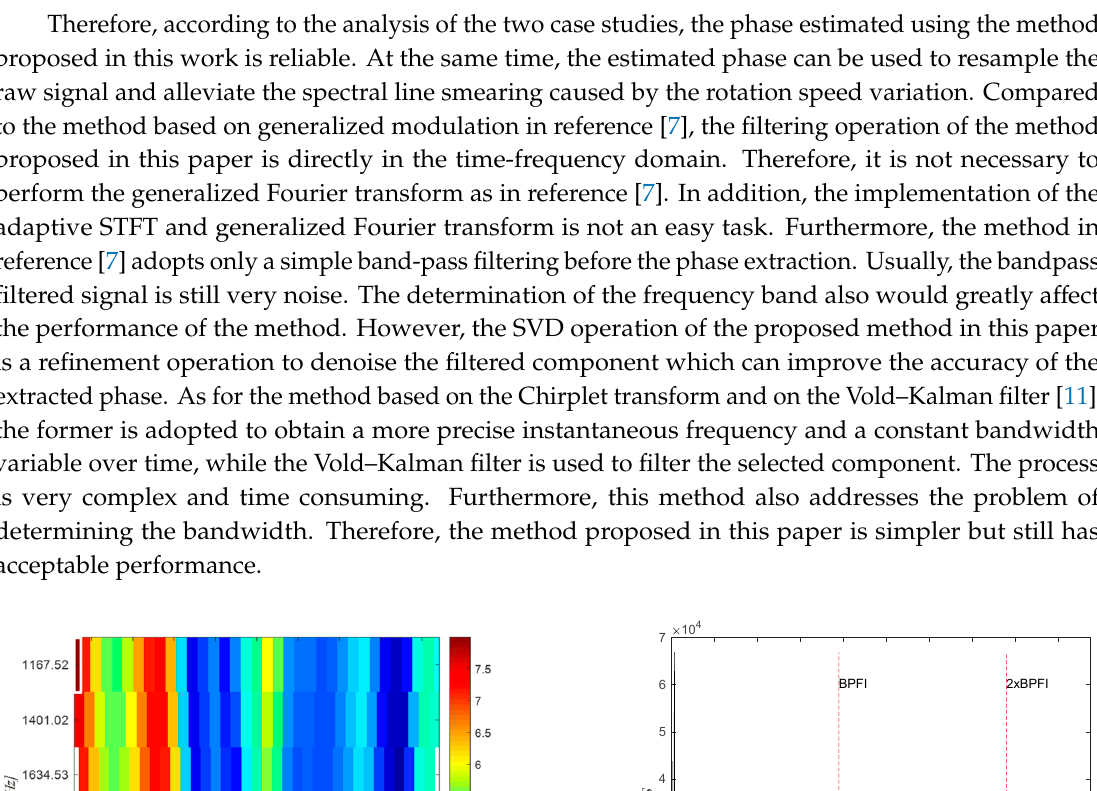
Figure 23. ( a ) The PMFSgram of the resampled signal; ( b ) the SES of the filtered signal.